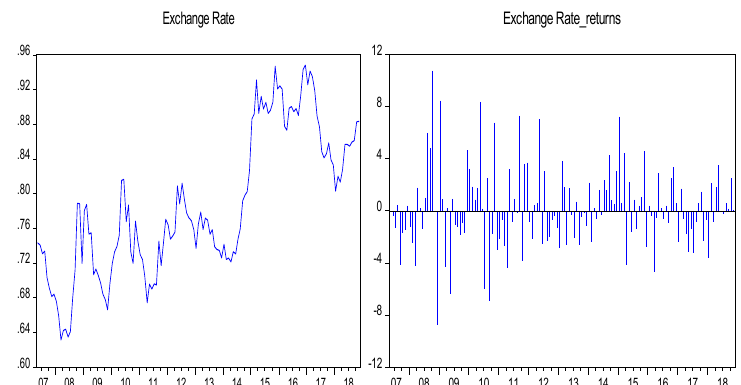
Figure 2. Time series volatility for OVX, WTI oil prices, S&P 500 index and exchange rate in levels ( left ) and returns ( right ) for the full sample between May 2007 and December 2018.